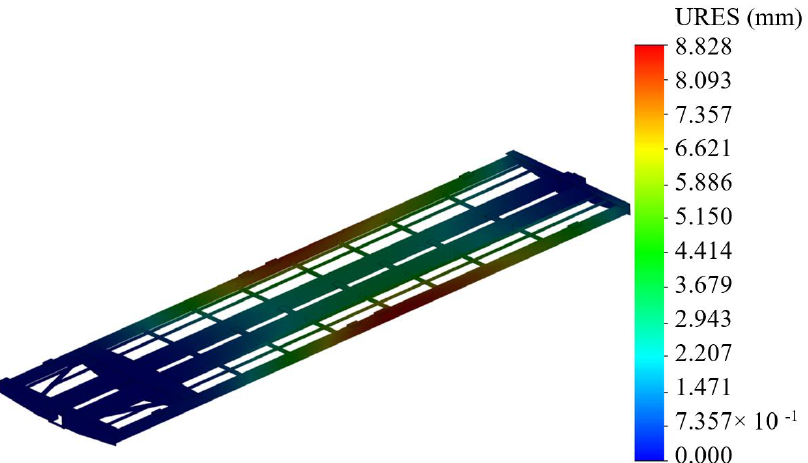
Figure 9. The displacements in the units of the carrying structure of the flat wagon section.